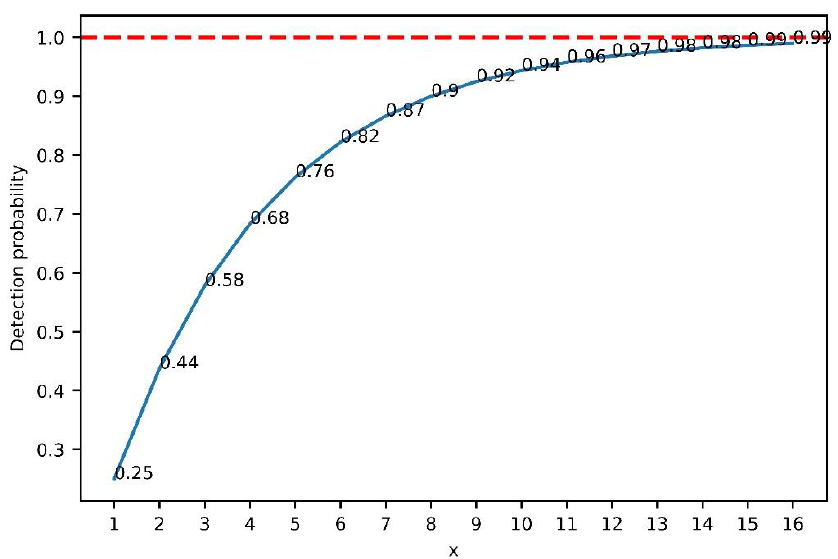
Figure 3. Detection probability of the measure and resend attack.